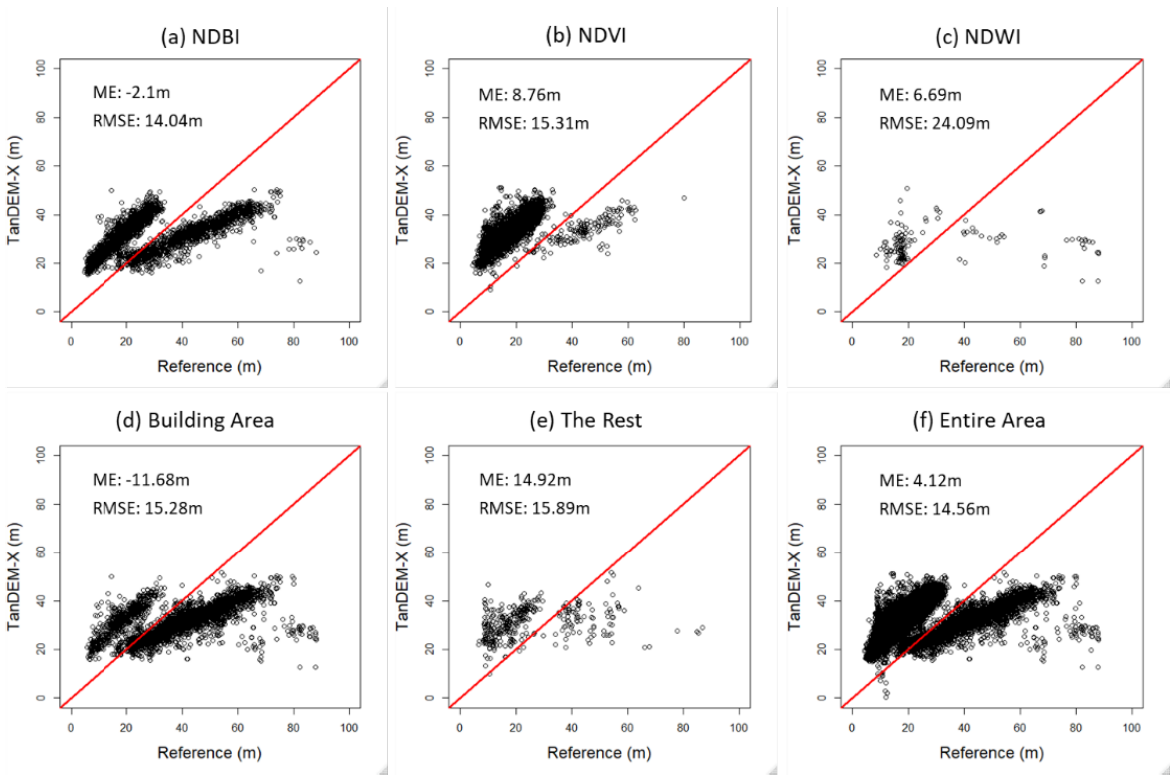
Figure 6. Scatterplots of TanDEM-X vs. the reference DEM and performance measures ME and RMSE: different land covers in Singapore: ( a ) NDBI, ( b ) NDVI, ( c ) NDWI, ( d ) Building Area, ( e ) The Rest, ( f ) The Entire Area .